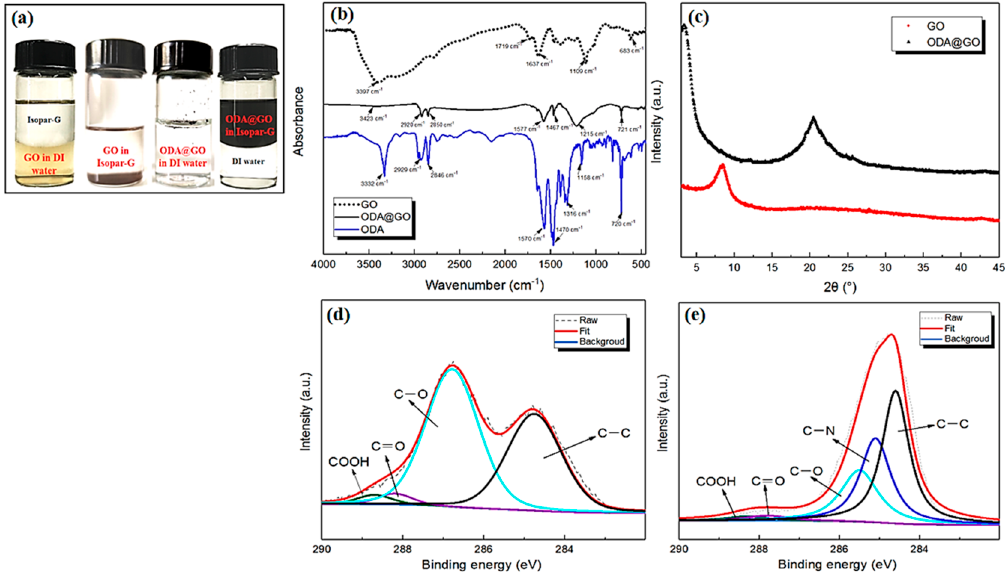
Figure 4. ( a ) Digital photos of GO and ODA@GO dispersion in solvents; ( b ) FTIR spectra of GO, ODA, and ODA@GO; ( c ) XRD analysis of GO and ODA@GO; ( d , e ) XPS-peak-differentiation-imitating analysis of GO and ODA@GO, respectively.